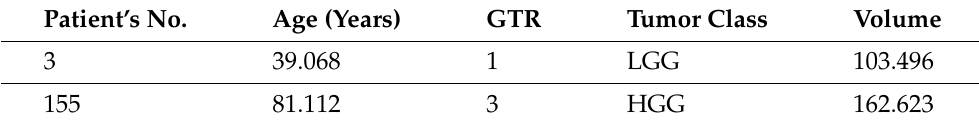
Figure 12. Survival rate for the HGG patient. Table 10. Input data for LGG and HGG